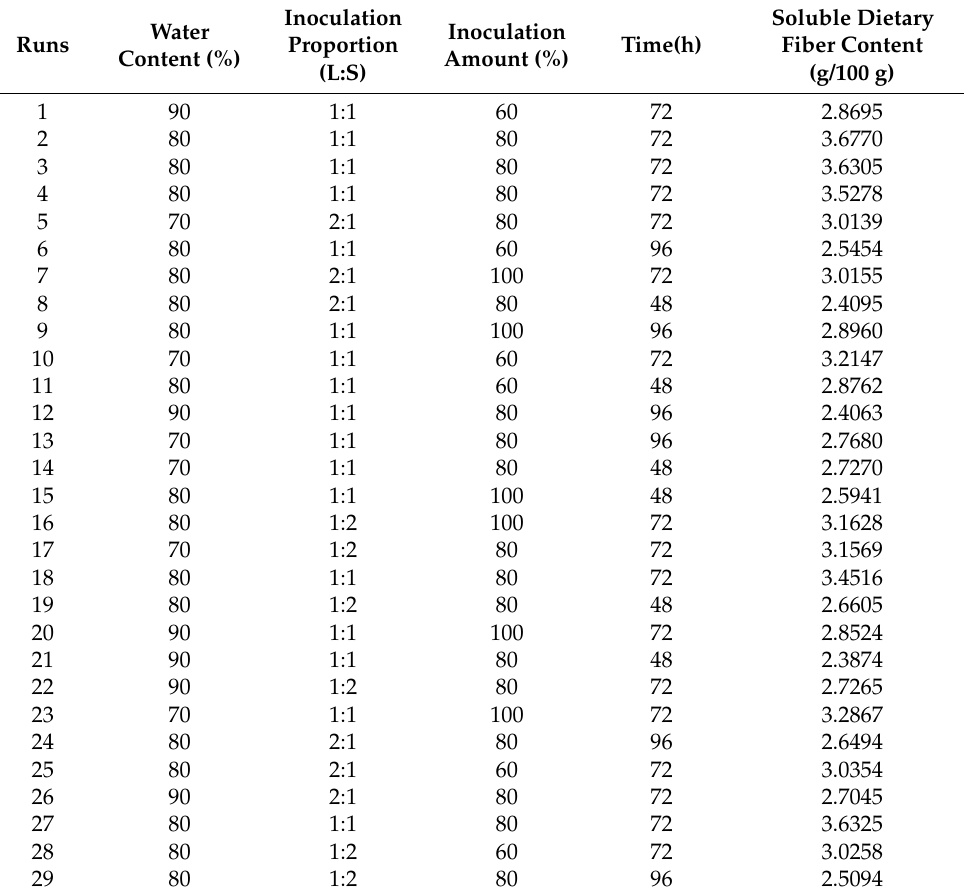
Table 2. Experimental data of the four-factor, three-level Box–Behnken designed for RSM and study